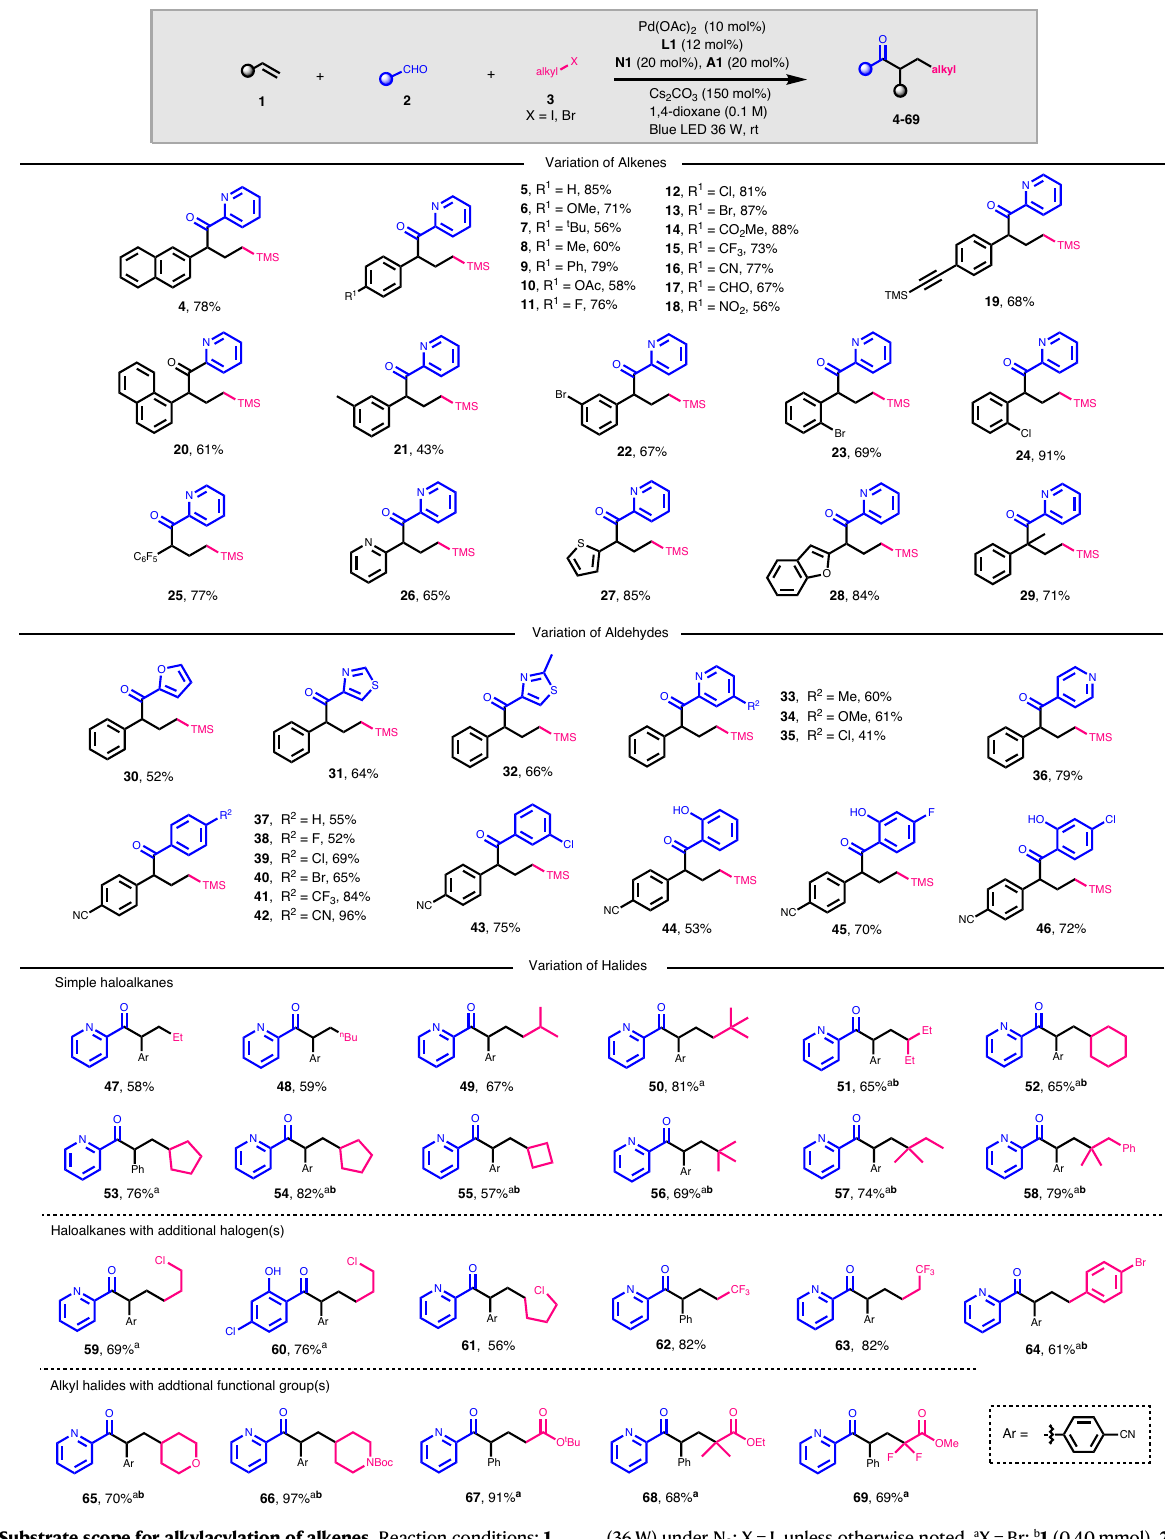
(36W) under N 2 ; X=I, unless otherwise noted. a X=Br; b 1 (0.40mmol), 2 (0.20mmol), and 3 (0.3mmol) were